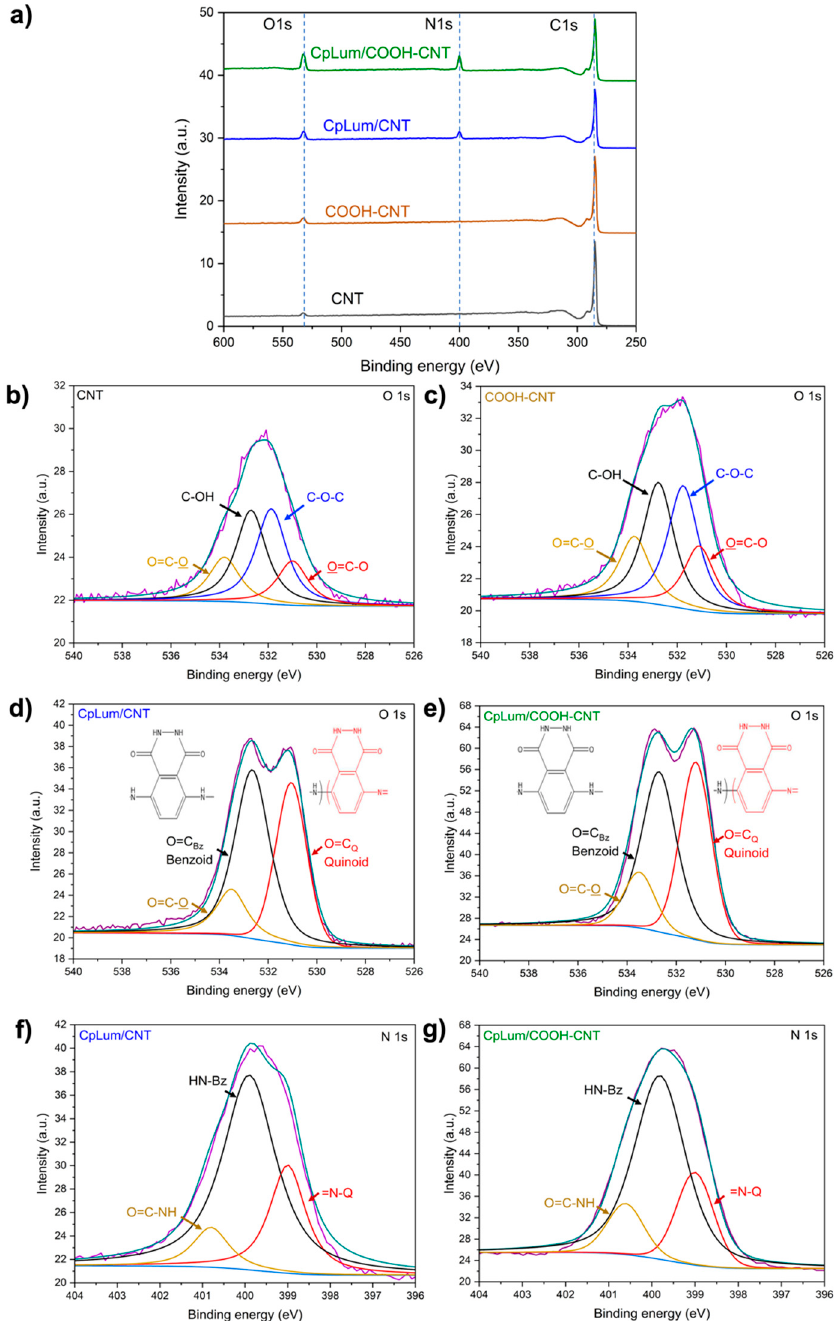
Figure 5. ( a ) XPS survey of CNT, COOH-CNT CpLum/CNT and CpLum/COOH-CNT, high-resolution spectra of ( b ) CNT O 1s, ( c ) COOH-CNT O 1s, ( d ) CpLum/CNT O 1s, ( e ) CpLum/COOH-CNT O 1s peak, ( f ) CpLum/CNT N 1s peak, and ( g ) CpLum/COOH-CNT N 1s peak. The raw data (pur- ple), the fit envelope (teal) and baseline (blue) has been included. Table 3. Elemental survey normalized atom percentages of C1s, O1s and N1s.